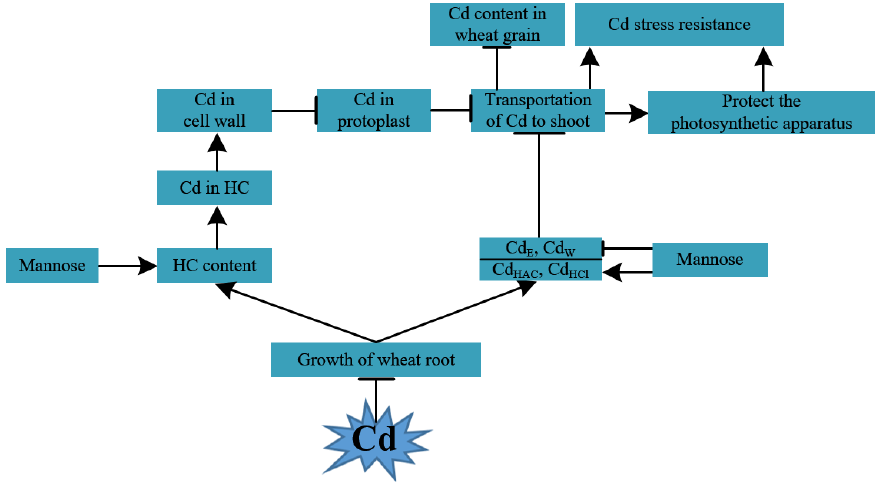
Figure 6. The working mode of MAN ‐ enhanced Cd tolerance of wheat under Cd stress.